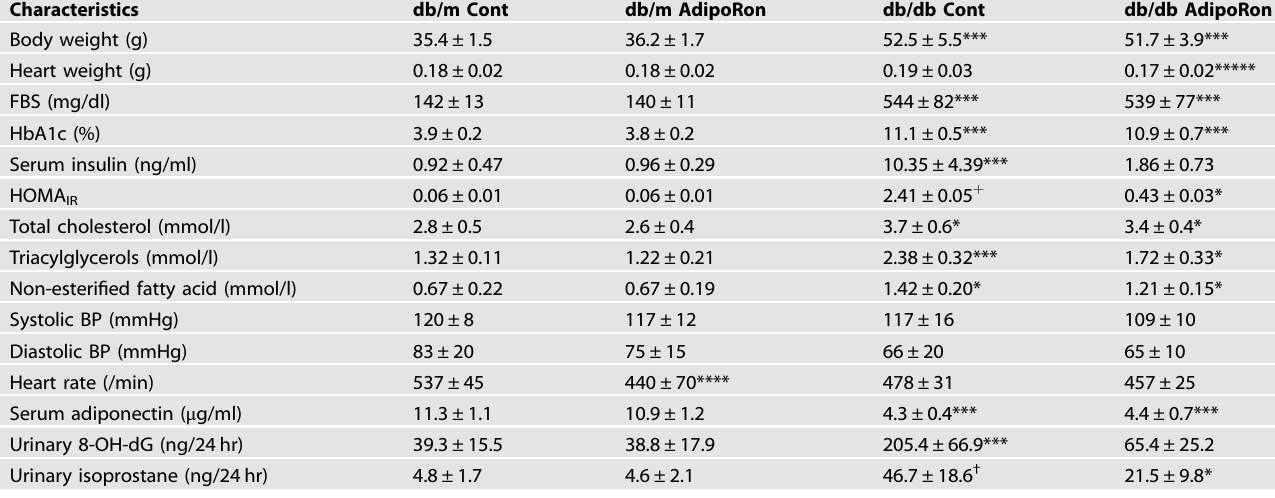
Table 1. Biochemical and physical characteristics of diabetic and non-diabetic mice after AdipoRon treatment.